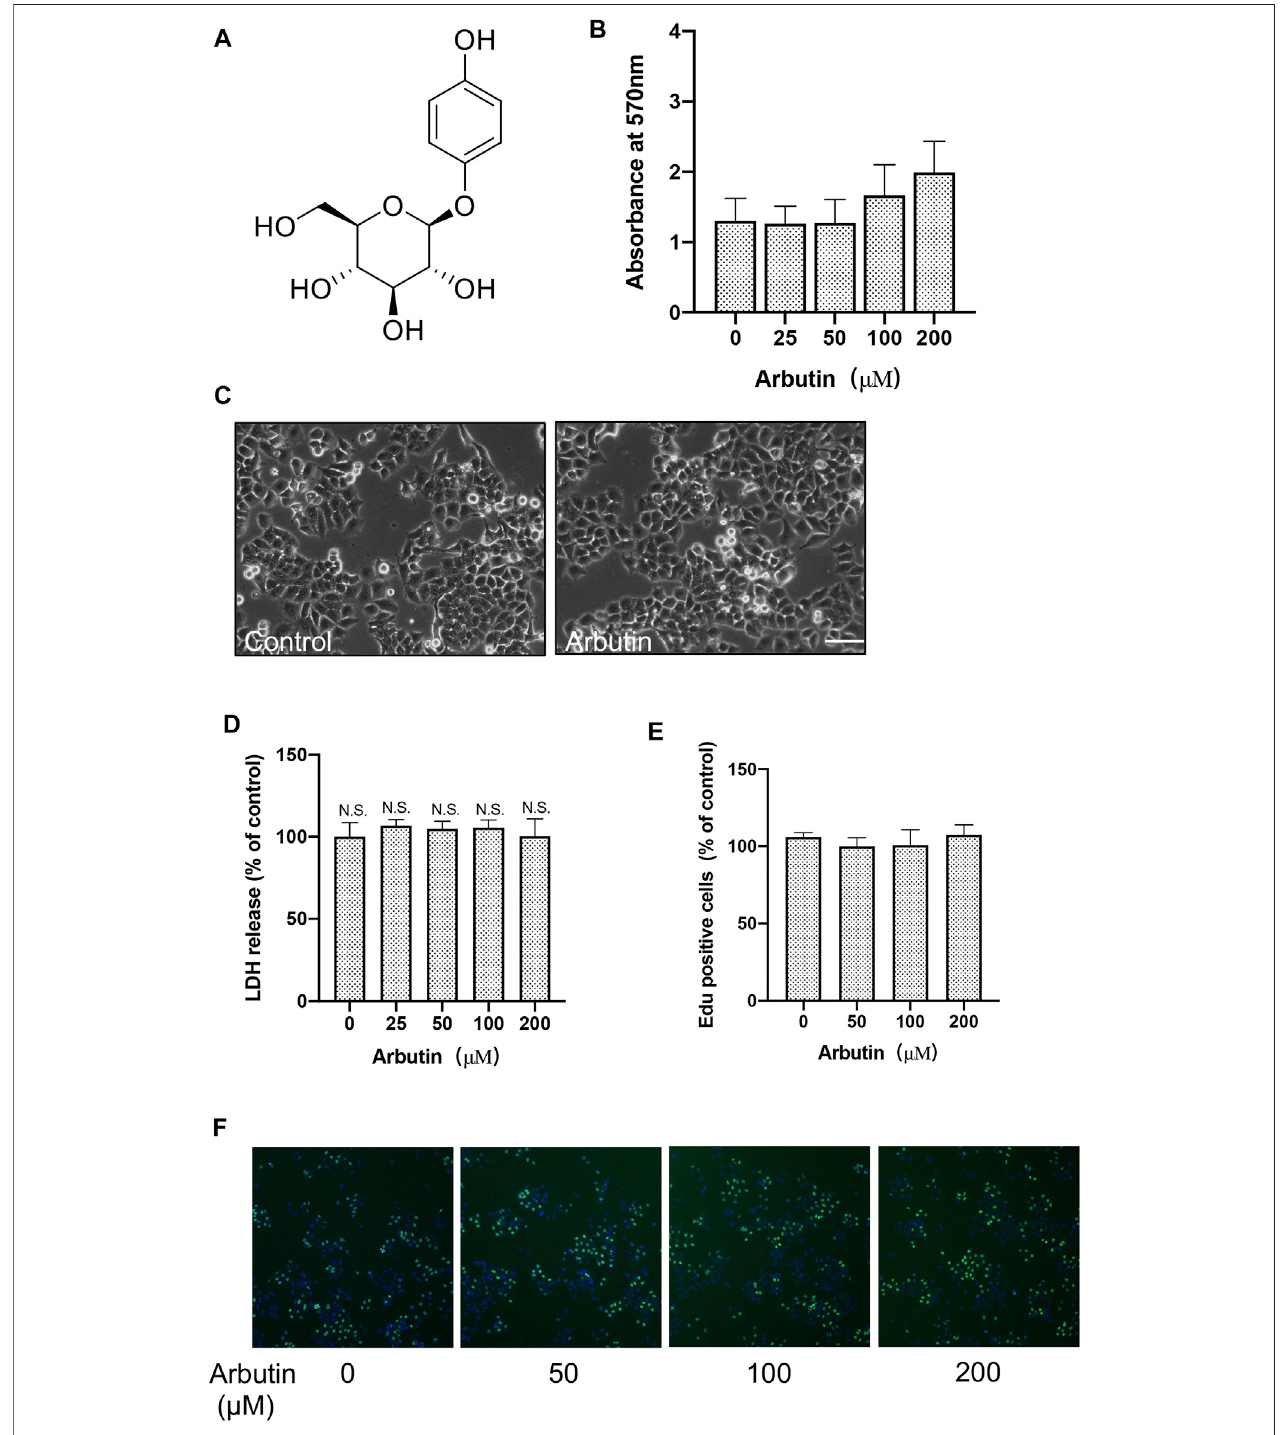
FIGURE 1 | Arbutin has no signi fi cant cytotoxic effects on hepatocytes. Effects of arbutin on survival viability and morphology of cells. (A) The structure for arbutin. (B) Cell viability with or without arbutin treatment was measure by MTT assay. (C) Morphologies of cells treated with arbutin for 24 h (D) LDH assay was performed with arbutin treatment in L-02 cells. (E) Cell proliferation was detected by EdU incorporation assay. (F) Proliferation was measured by EdU assay. Representative images are shown.